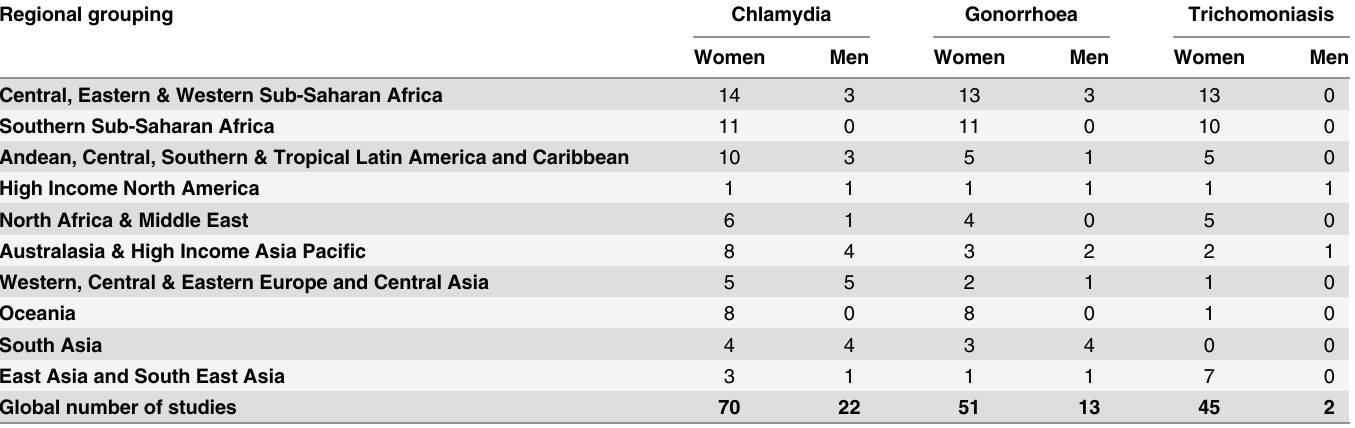
Table 3. Number of data points that met the study inclusion criteria for WHO 2012 estimates by infection, region, and sex. Note: A total of 79 studies were identified, but only some provided information for all three infections. For the High Income North America region, the estimates were based on the United States national